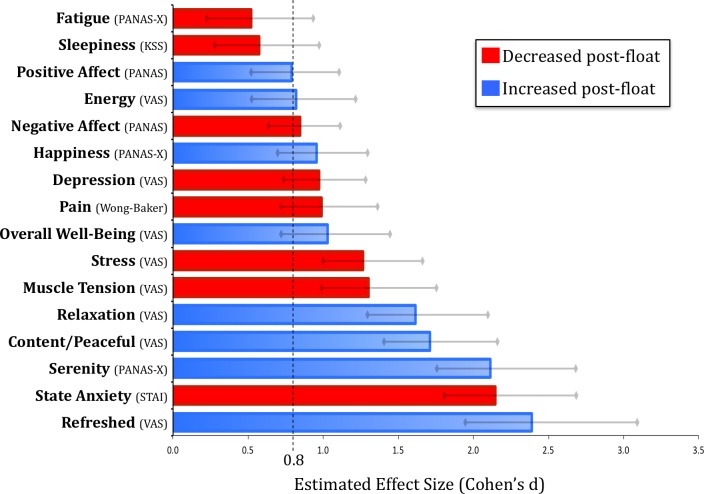
Estimated effect size of a single float session in patients with anxiety and depression.The estimated Cohen’s d is shown for each pre- to post-float change score, with grey lines representing the 95% confidence interval. The dashed black line demarcates the starting point (d = 0.8) for what is considered a “large effect size” [73].